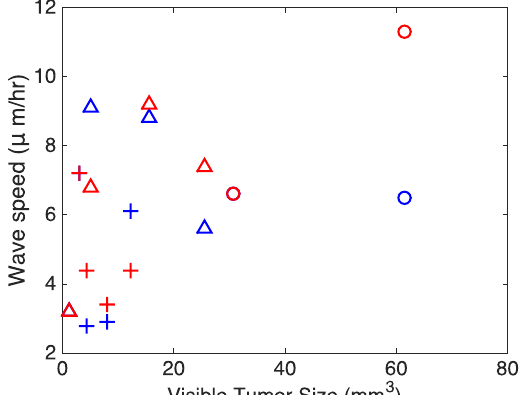
Figure 3. Dependence of wave speed of tumor on tumor size. The wave speed (velocity) of the tumor is calculated by ρ D 2 . Blue markers show results from parameters optimized under Hypothesis 2; red markers, Hypothesis 3. Triangles: Mouse 1; pluses: Mouse 2; circles: Mouse 3.